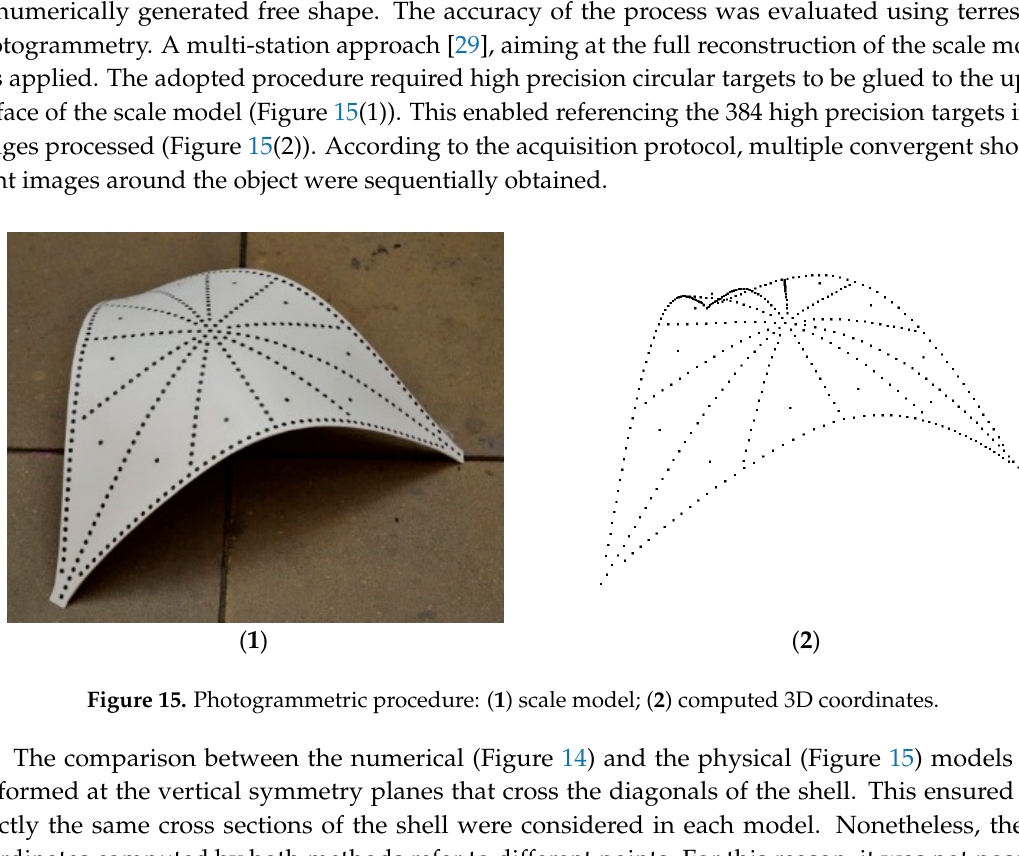
Figure 14. Free-form shell generated using a geometrically nonlinear analysis [10].